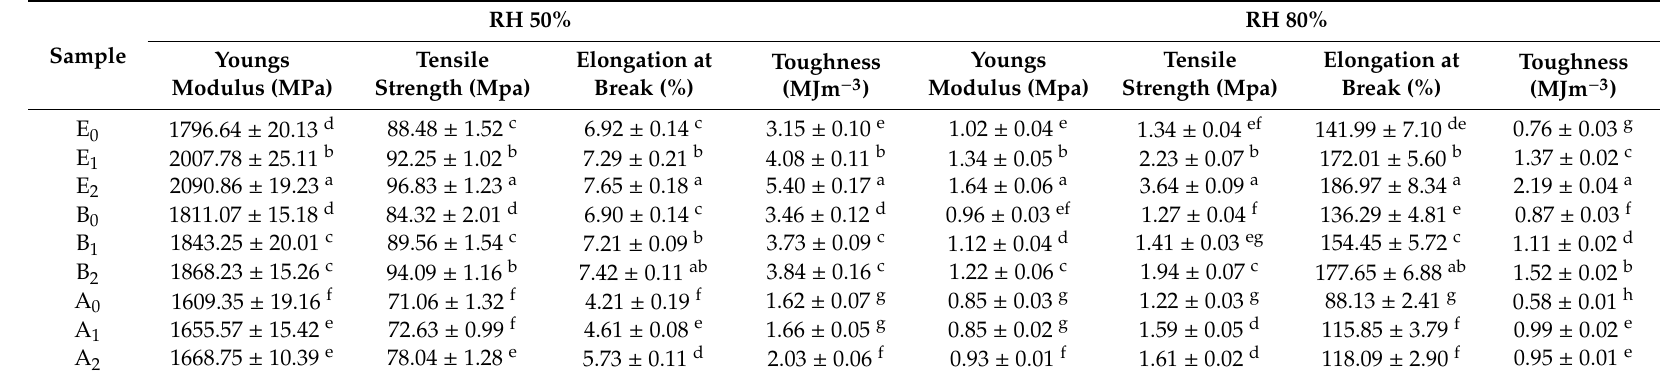
Table 3. Mechanical properties of gelatin films under di ff erent